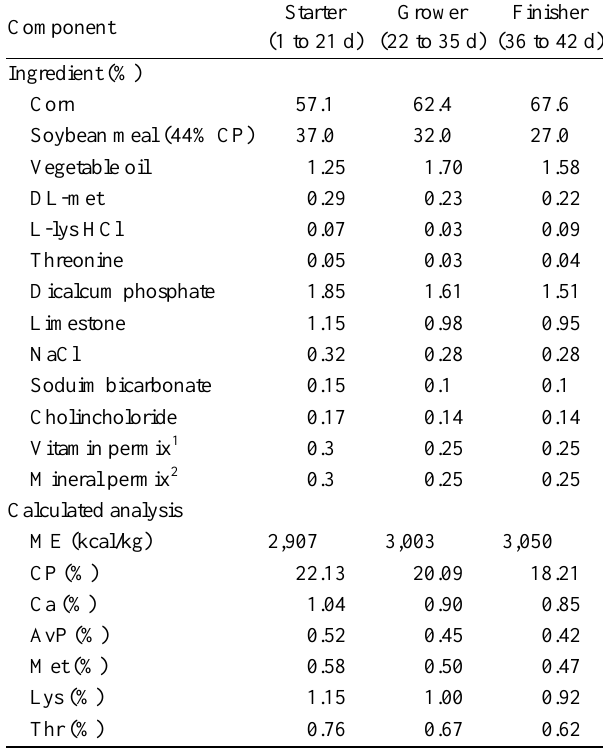
Table 1. Feed composition and ingredients of experiment